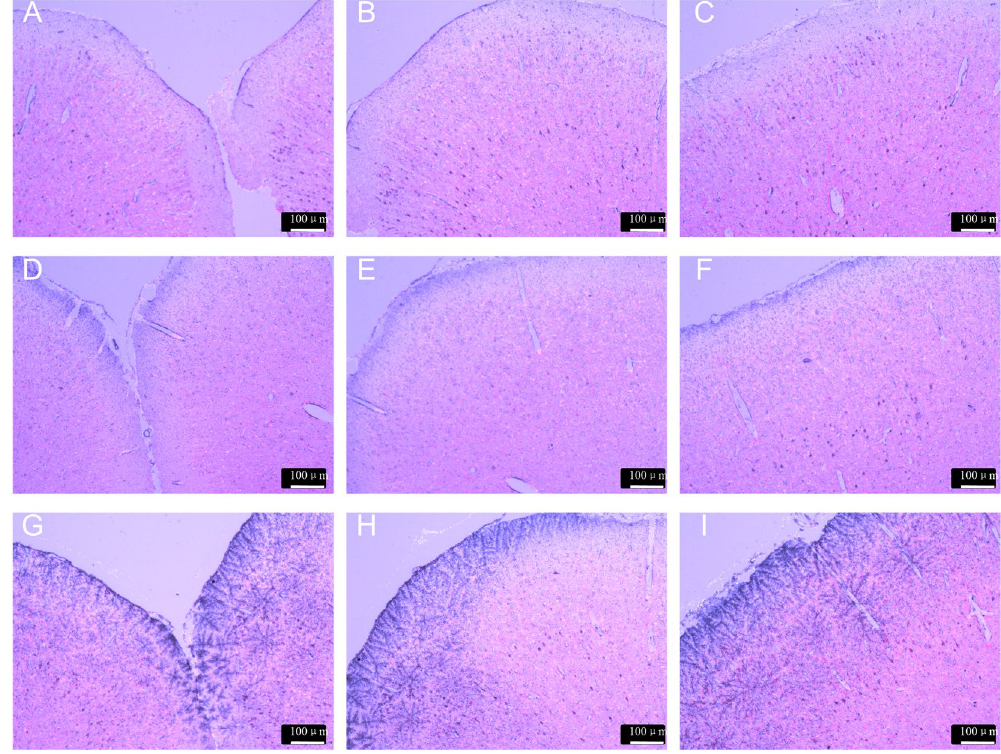
Figure 8. Analysis of β -gal enzyme activity assessed by β -Gal kit staining in the enlarged images. ( A – C ) β -gal saline; ( D – F ) β -gal-loaded F127 micelles; ( G – I ) β -gal-loaded FT mixed micelles (Scale bar: 100 μ